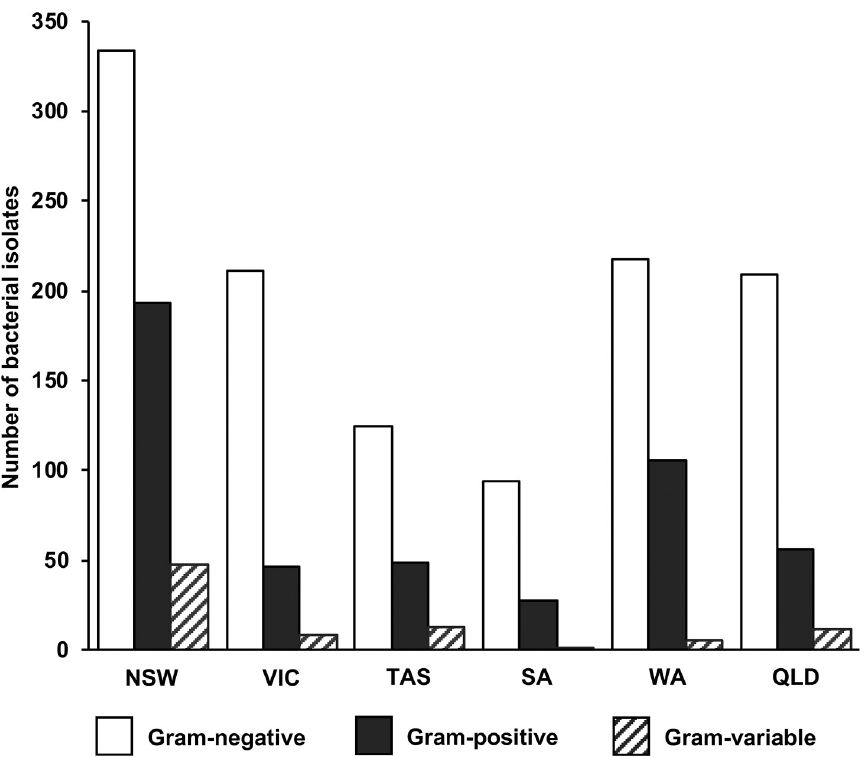
Fig 5. Gram staining properties of aerobic gut bacteria isolated from European nurse honey bees from in Australia. Isolates were analyzed from New South Wales (NSW), Victoria (VIC), Tasmania (TAS), South Australia (SA), Western Australia (WA), and Queensland